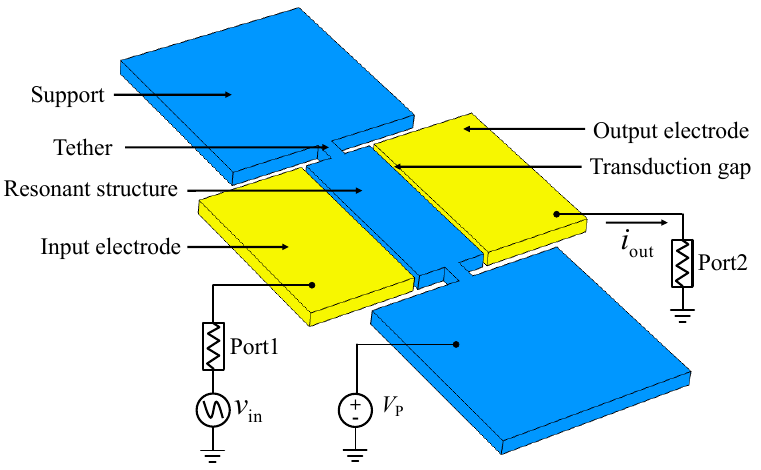
Figure 3. The schematic of the WEM resonator.